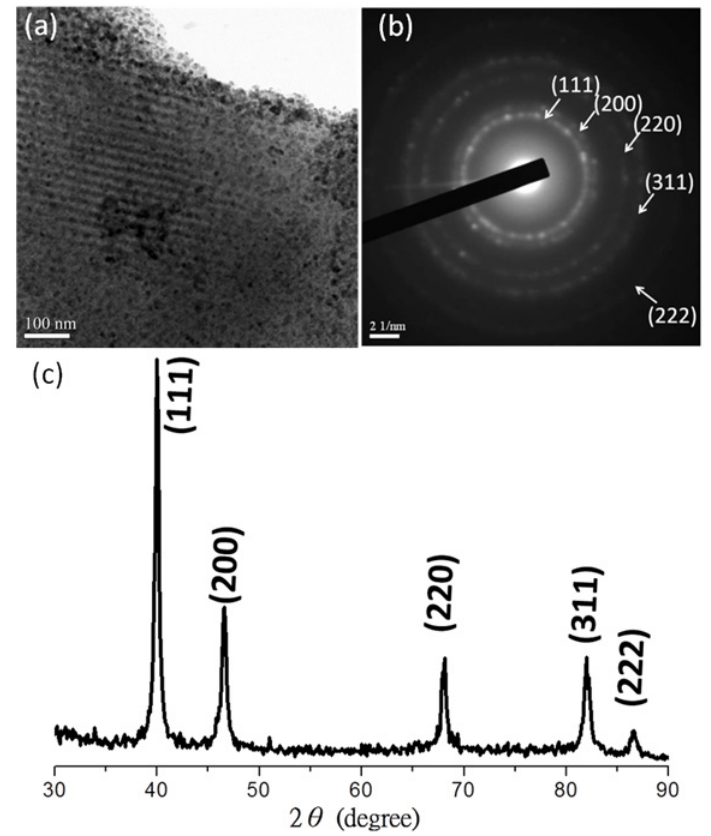
Figure 5. ( a ) TEM images; ( b ) selected-area electron diffraction pattern; and ( c ) powder XRD pattern of the Ag/cylindrical mesoporous carbon